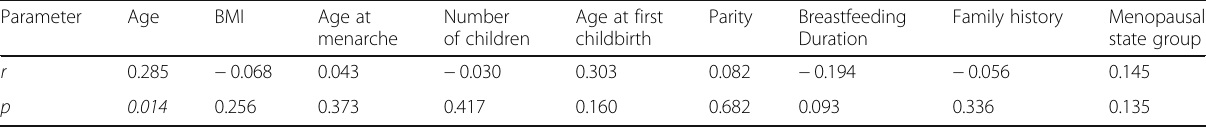
Table 4 Correlation of p14/ARF methylation percentage with breast cancer risk factors